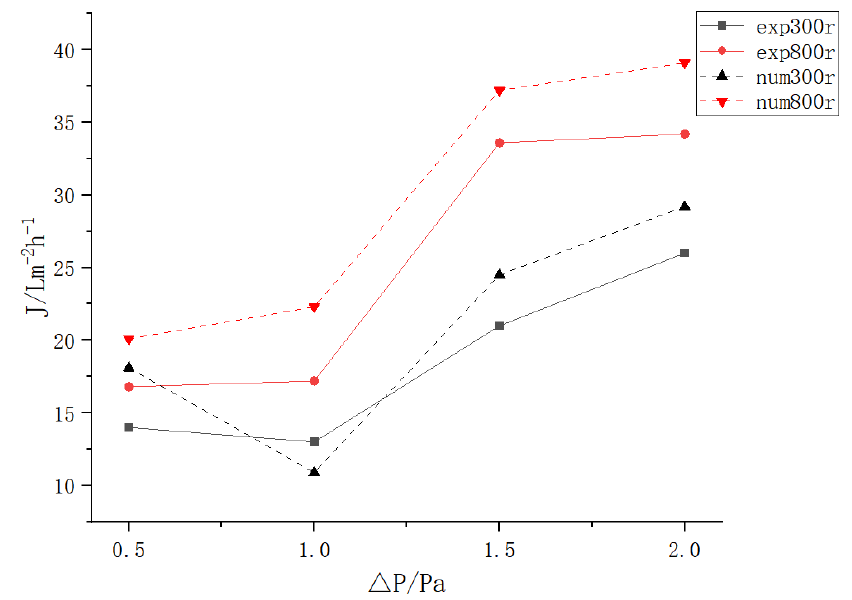
Figure 16. Diagram of the vane-stirred dynamic cross-flow experimental equipment flux.